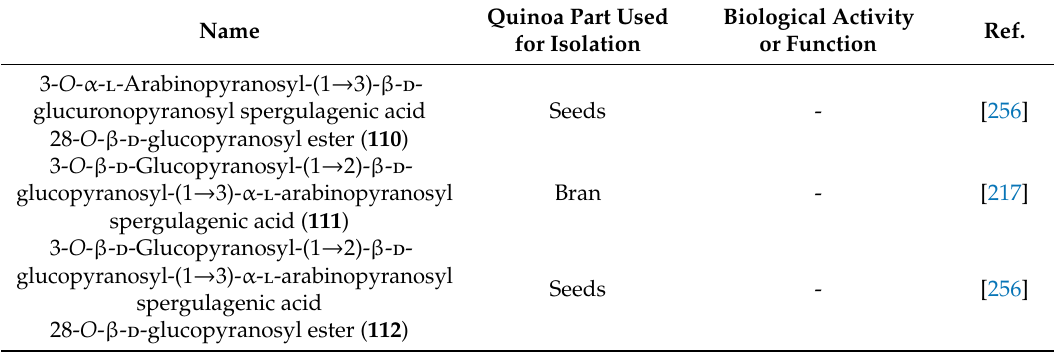
Table 11. Spergulagenic acid derivatives and their biological activities or